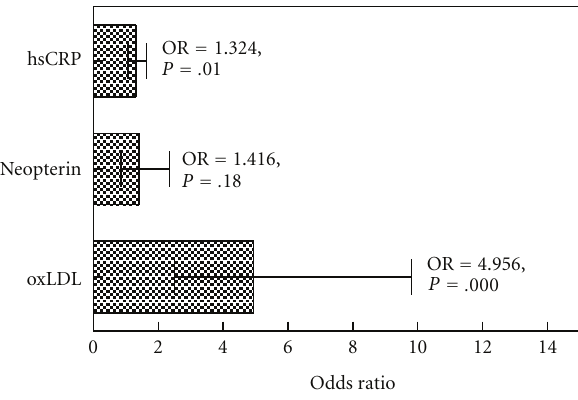
Figure 1: Error bar plot showing the odds ratio and 95% CI for hsCRP, neopterin and oxLDL towards risk of developing metabolic syndrome.